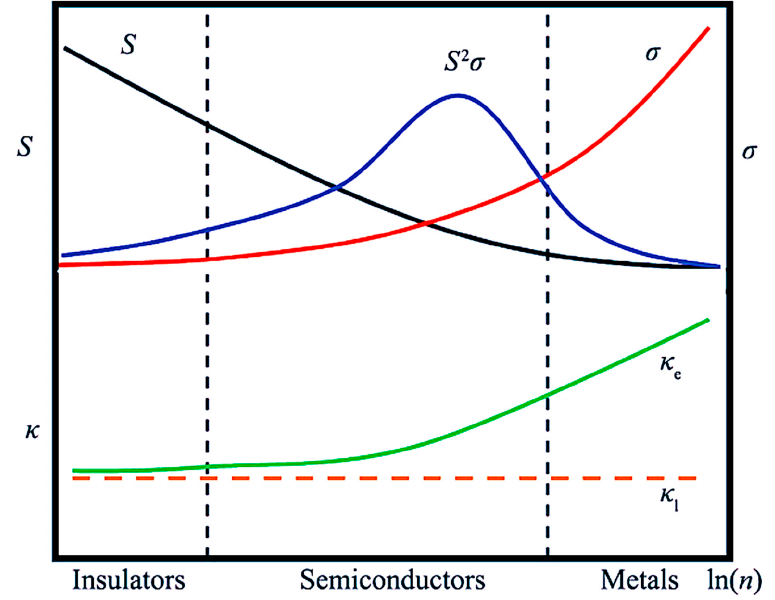
Figure 1. Correlation of thermoelectric parameters and carrier concentrations.